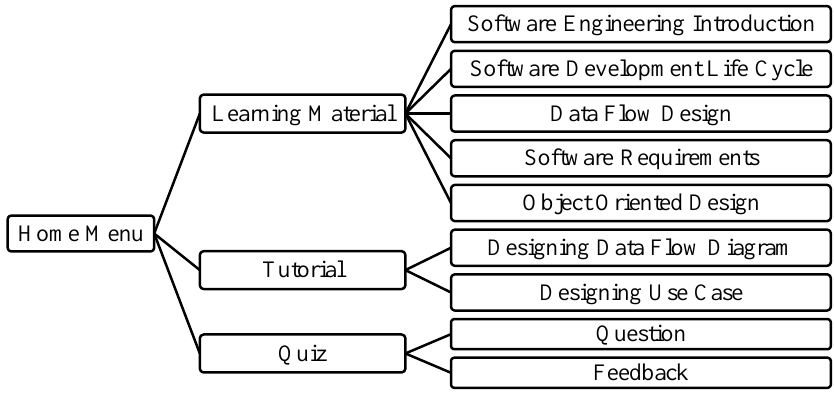
Fig. 2. Content Framework for Teaching